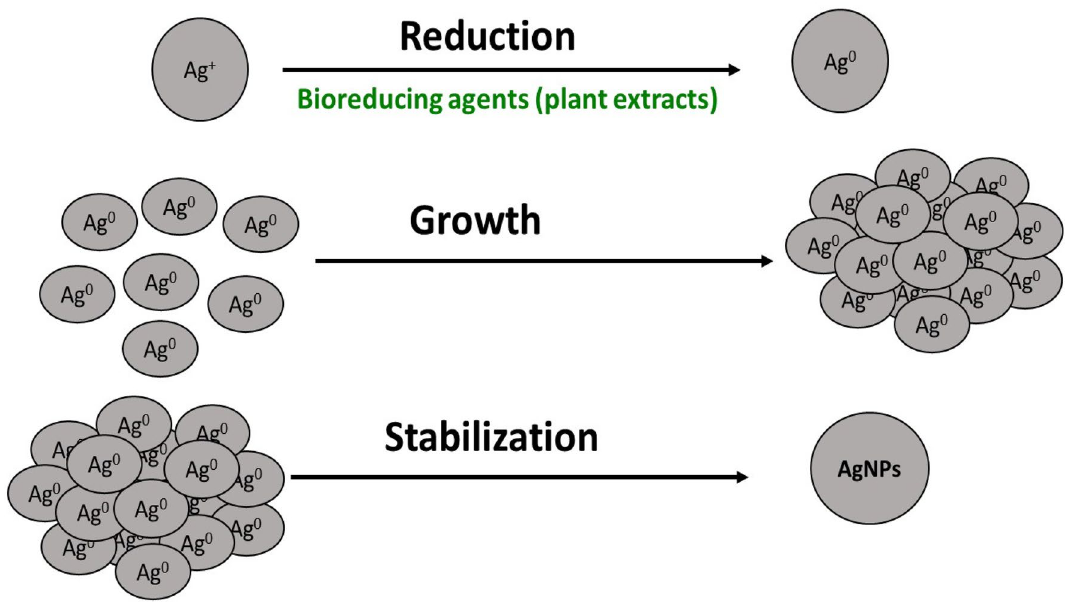
Figure 3. Proposed mechanism of the synthesis of AgNPs using plant extracts